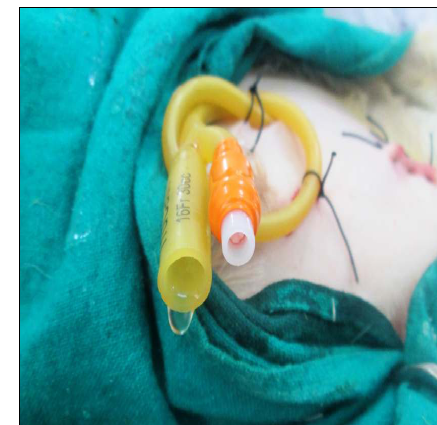
Figure-1: Skin incision at anterior to the rudimentary teat.